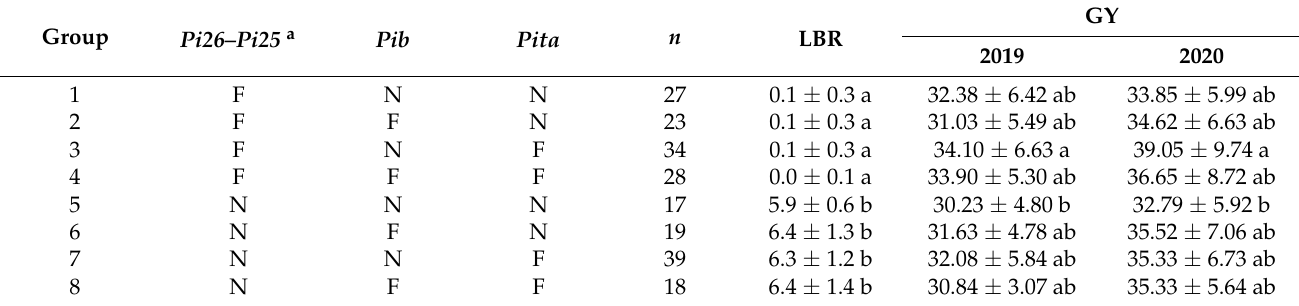
Table 6. Phenotypic performance of LBR and GY in the different combinations of the four